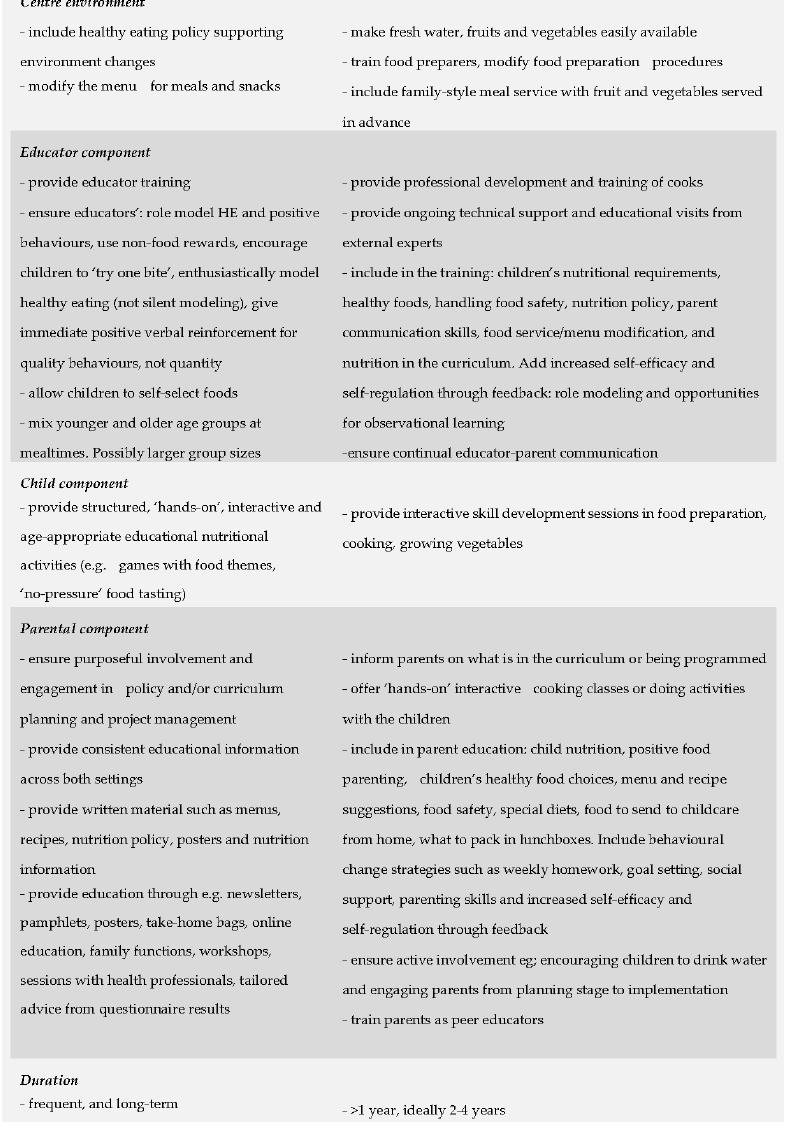
Figure 1. List of summarised multi-strategy, multi-level intervention characteristics.